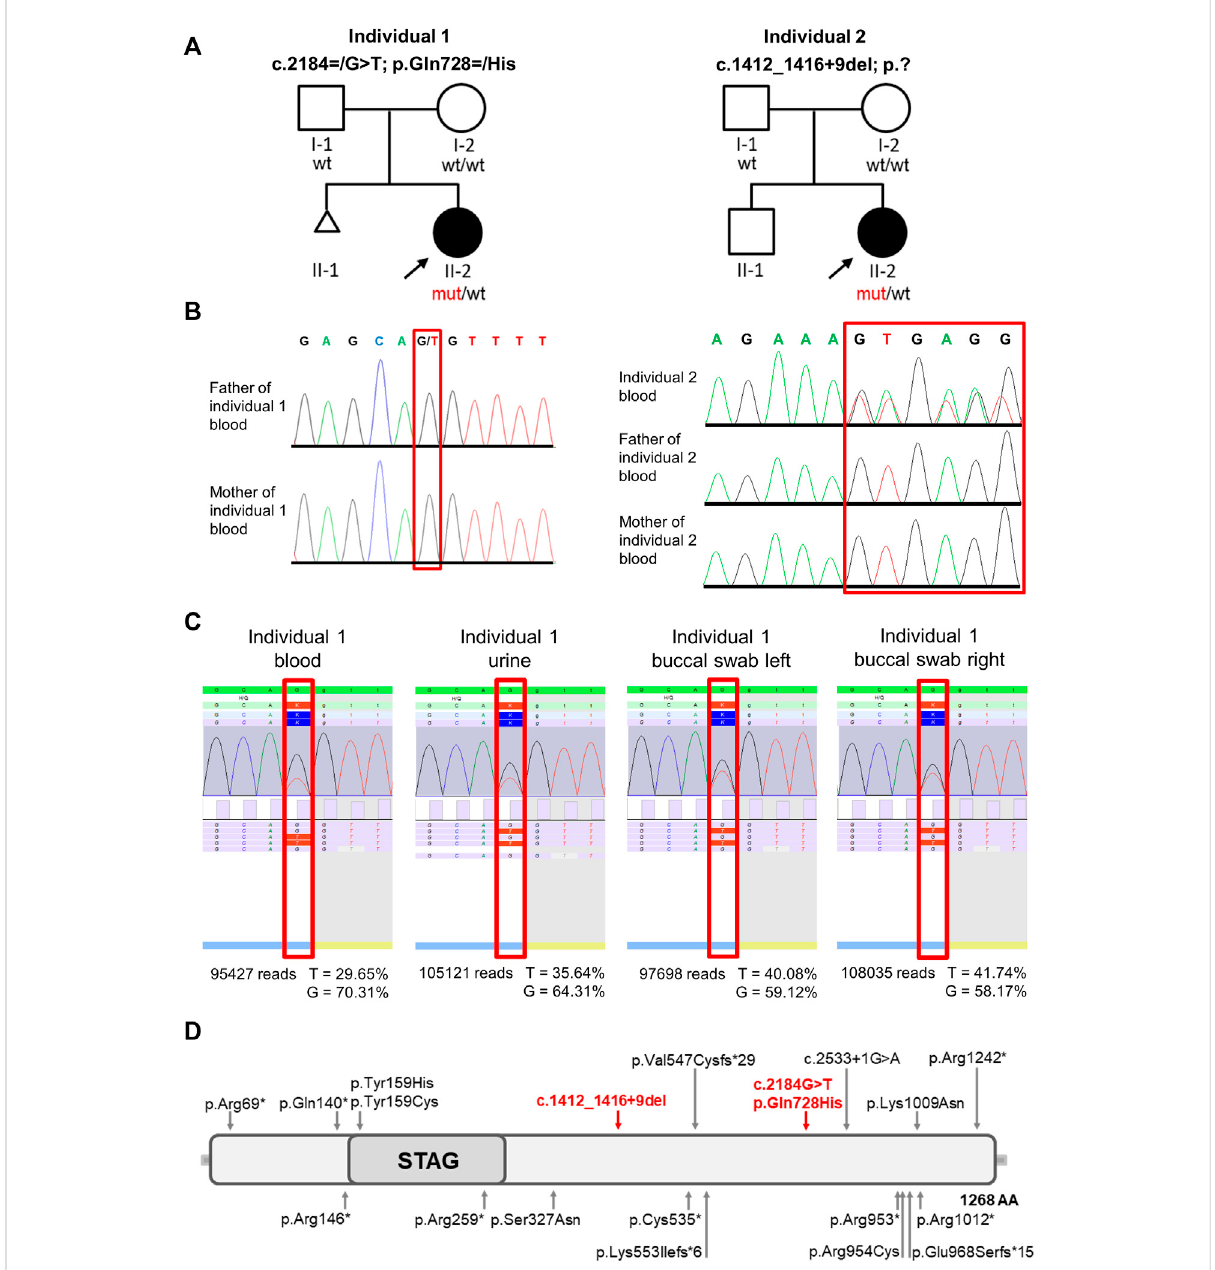
FIGURE 3 Pedigrees, molecular fi ndings, structure of STAG2 protein and location of the identi fi ed variants. (A) Pedigrees of the 2 families included in this study. Affected and unaffected individuals are indicated by fi lled and open squares (males) and circles (females), respectively. (B) Electropherograms show that the STAG2 variant c. 2184G > T p.(Gln728 > His) is not detectable in blood samples of both unaffected parents of individual 1 and that the heterozygous STAG2 variantc.1412_1416+9del(p.?)inindividual2isnotdetectableinbloodsamplesofbothunaffectedparentsofindividual2. (C) Deep sequencing analysis was used to validate the exome data and con fi rmed the mosaic STAG2 variant c.2184=/G > T p.(Gln728=/His): The variant was present in 29.65% of the 95,427 reads from the EDTA blood sample, in 35.64% of the 105,121 reads from urine, in 40.08% of the 97,698 reads from the buccal swab (left side) and in 41.74% of the 108,035 reads from the buccal swab (right side). (D) Identi fi ed variants and schematic overview of their location within the STAG2 protein. Red arrows point to the locations of the 2 variants identi fi ed in this study, previously reported variants are indicated by grey